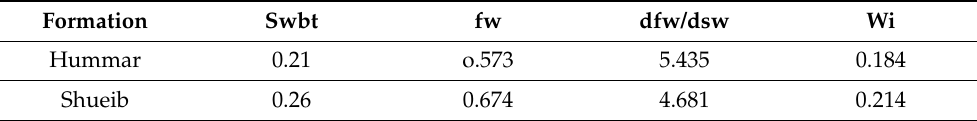
Table 11. Summary calculation of the data of the breakthrough of water saturation.